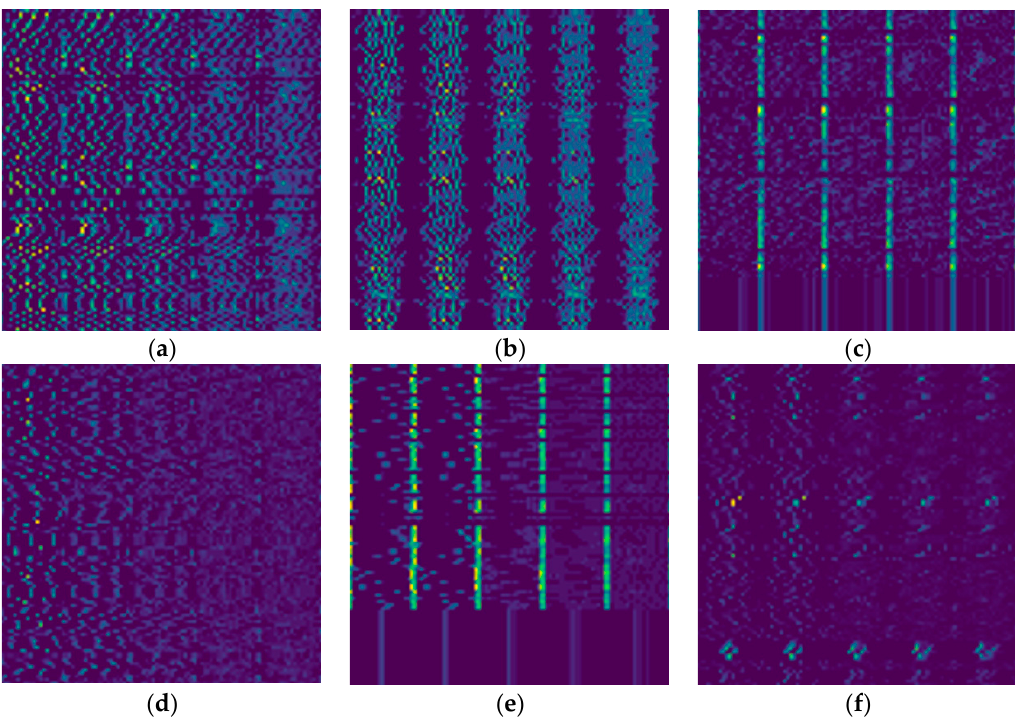
Figure 9. Examples of the 2D local Hough spaces generated from 6 object samples: ( a ) pole, ( b ) pedestrian, ( c ) tree, ( d ) bush, ( e ) building, ( f ) vehicle.